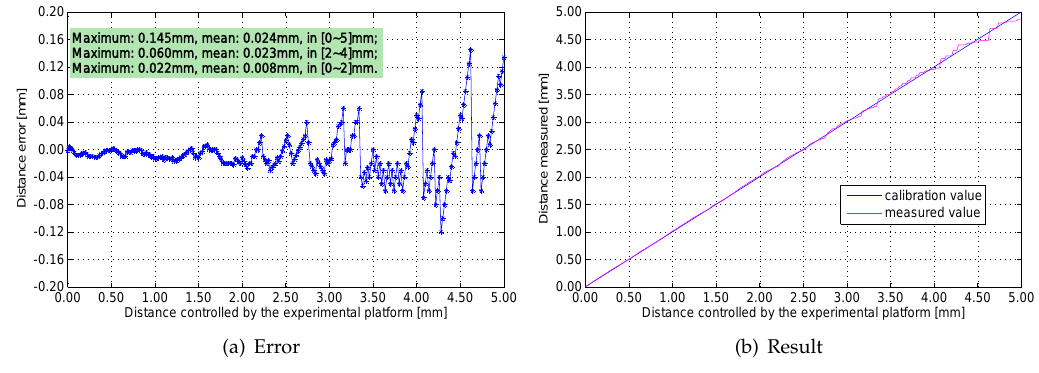
Figure 18. Measurement errors and results at 80 ◦ C.